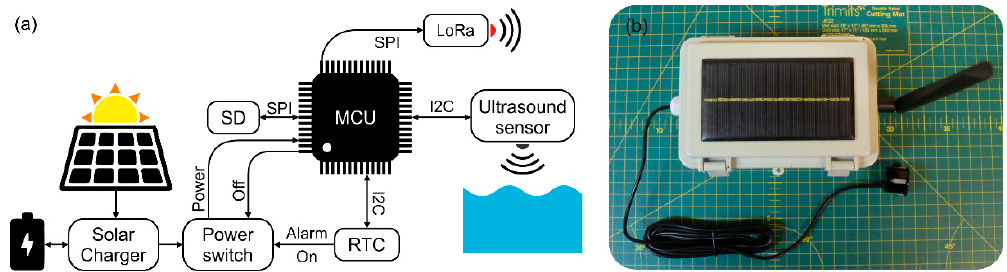
Figure 2. The architecture of the node. ( a ) Connections. ( b ) MS Ultra.